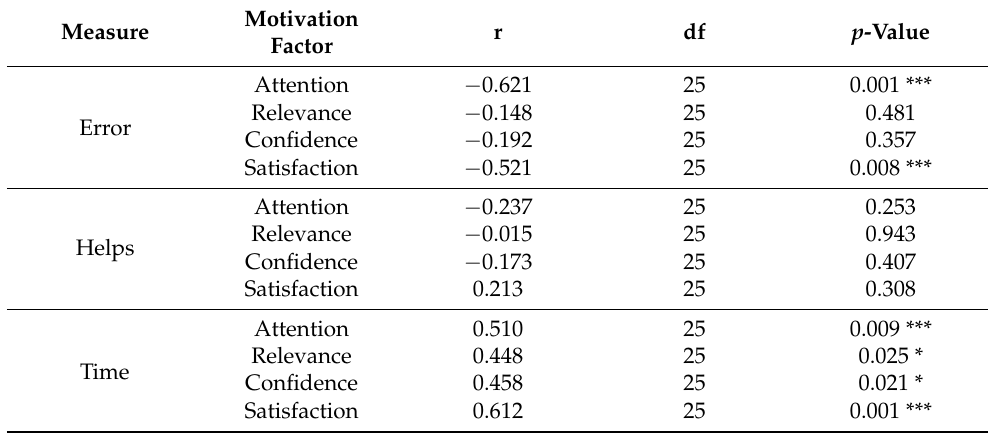
Table 4. Correlation results between motivational factors and students’ interaction with the AR-based learning environment in the experimental group.